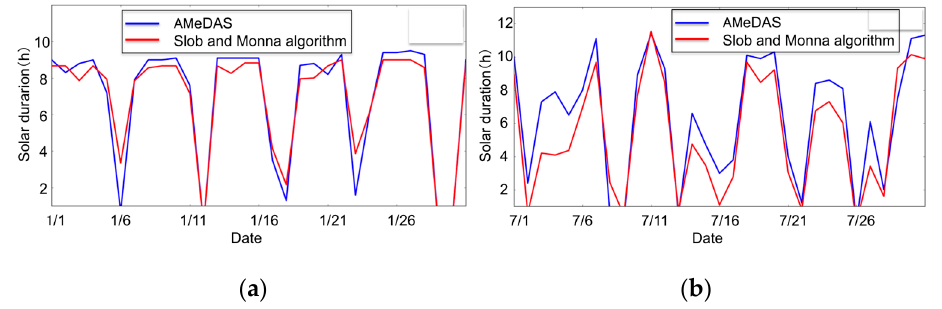
Figure 13. Data verification about solar duration: ( a ) The data acquired in January; ( b ) The data acquired in July.